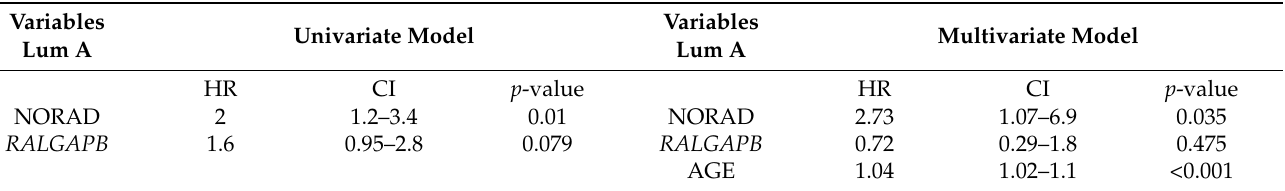
Table 1. Univariate and Multivariate Cox regression analyses for NORAD and RALGAPB in Lum A